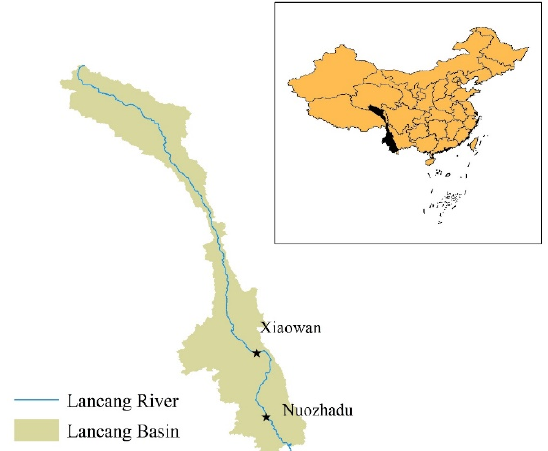
Figure 1. Reginal location of Xiaowan and Nuozhadu reservoir.